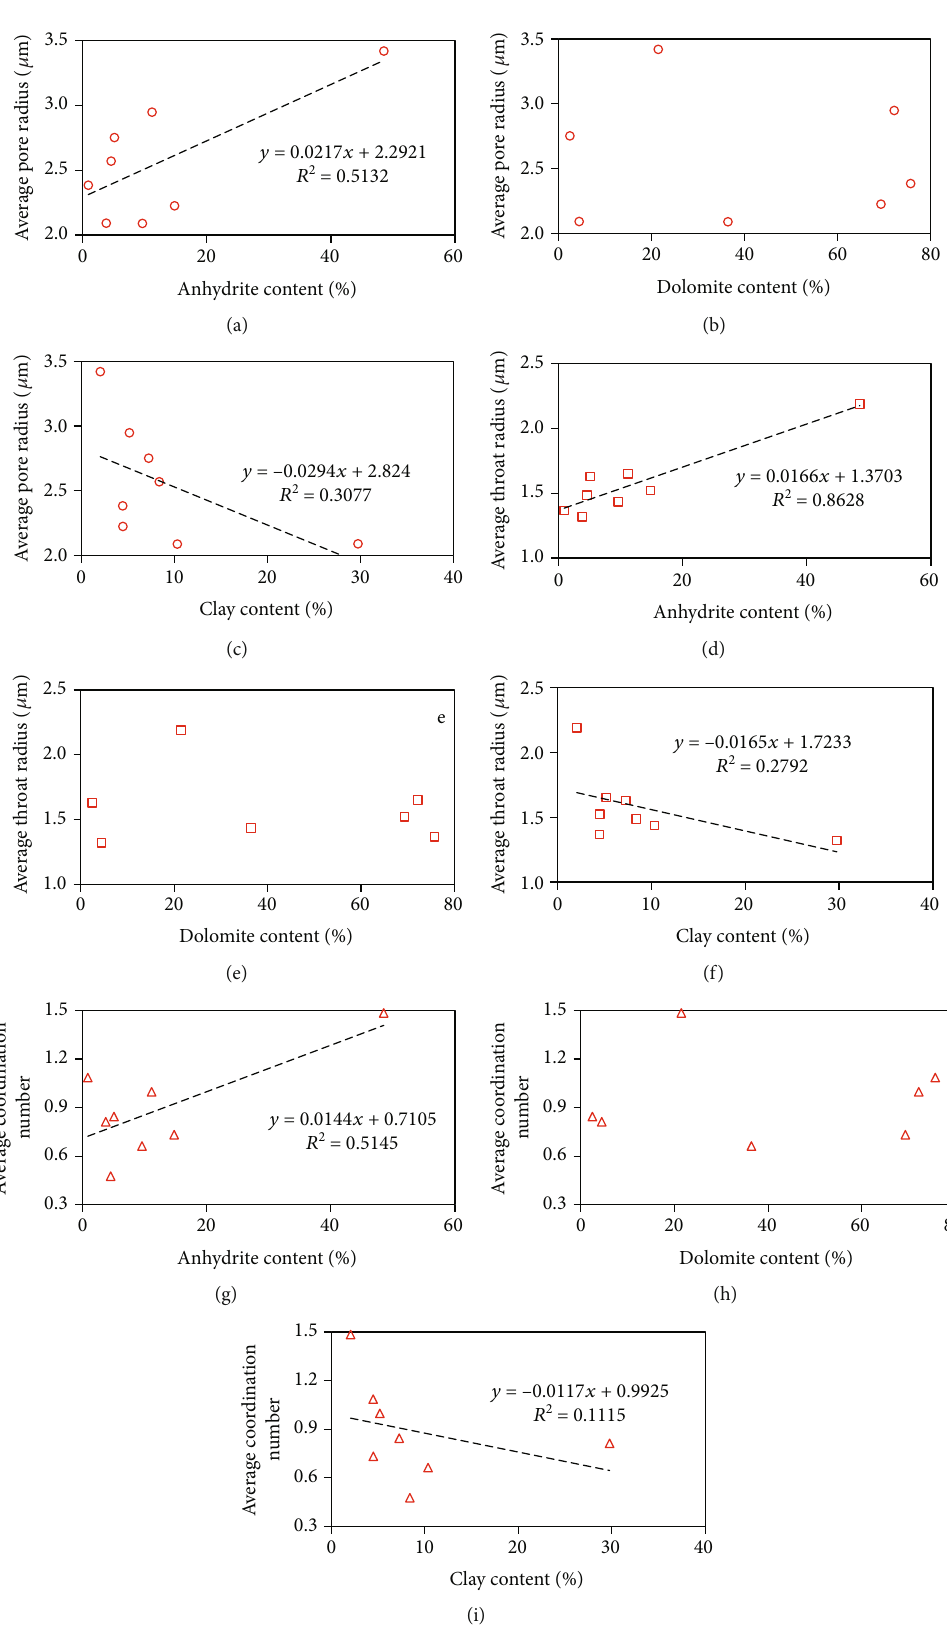
Figure 9: Crossplots of 3D CT parameters and mineral compositions of the eight